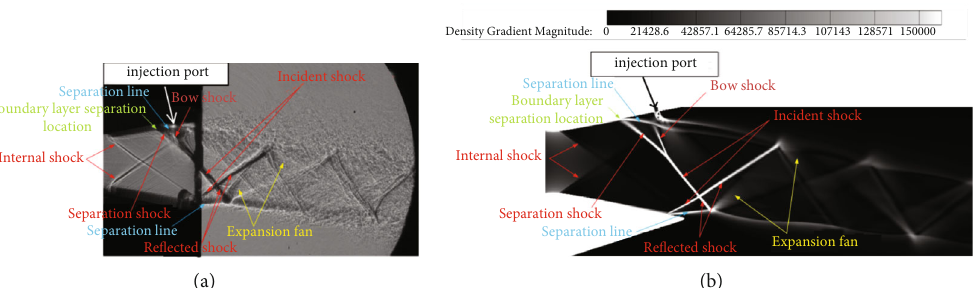
Figure 6: Comparison between experimental shadowgraph and CFD results: (a) experimental shadowgraph; (b) CFD.